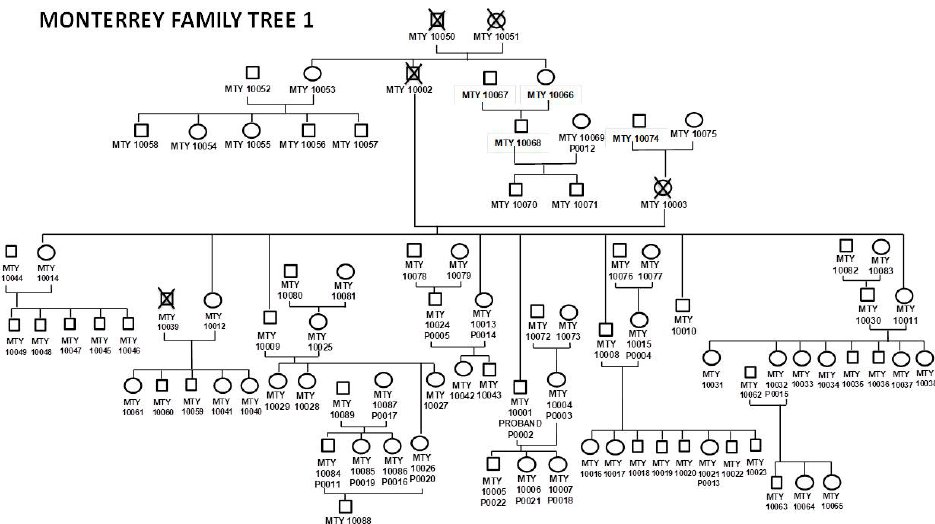
Figure 2. Three-generation family tree from Monterrey, Mexico as an example of the typical extended pedigrees recruited in the GEMM Study. Proband: MTY1001 (P002). Proband’s wife: MTY1002 (P004). Founders: MTY 10050&51 (deceased). Proband’s parents: MTY1002&03 (deceased). Brothers and sisters: MTY 1011, 10, 08, 13 (P0014), 09, 12, 14. Daughters: MTY1006 (P021) and 07 (P018). Son: MTY 1005 (P022). P00: Participants that have already volunteered for the postprandial/biopsy procedures. Female—circles;